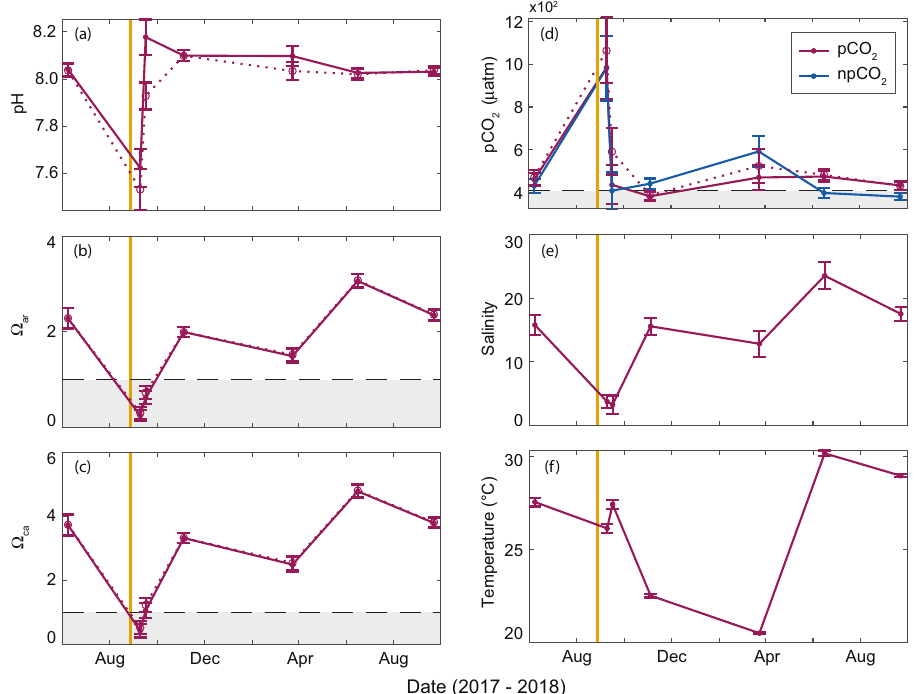
Fig. 2 Time series of temperature, salinity, and carbonate chemistry in Galveston Bay from June 2017 to September 2018. Average values and standard error for discreet sampling time points of a pH, b aragonite saturation state ( Ω ar ), c calcite saturation state ( Ω ca ), d in situ partial pressure of carbon dioxide (pCO 2 ; red) and temperature-normalized pCO 2 (npCO 2 ; blue) to 26.0 °C (average in situ temperature across sampling period), e salinity, and f temperature. Solid lines show carbonate parameters calculated using constants from Millero 41 recommended for estuaries; dotted lines with open circles show carbonate parameters calculated using Lueker et al. 42 constants recommended for seawater (S > 15). The gray horizontal shading in ( b ) and ( c ) indicates undersaturated conditions ( Ω < 1) and in ( d ) represents average atmospheric CO 2 levels (~405 μ atm) during the study. The yellow vertical bar shows the period of August 26 – 30 associated with heavy rainfall in the Houston area associated with Hurricane